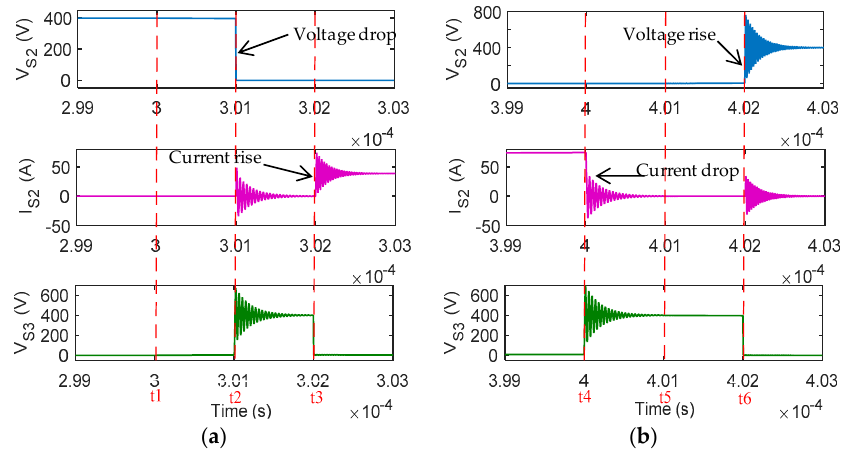
Figure 6. Simulation results of double pulse test for the hybrid switches (T d1 = 2 us; T d2 = 1 us) ( a ) Turn-on; and, ( b ) Turn-off.